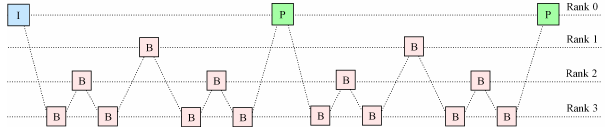
Fig. 1: HBR Coding Scheme